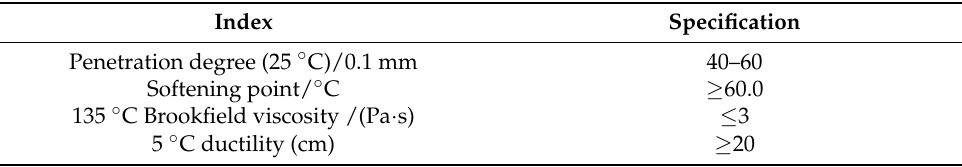
Figure 4. Relationship between Proportion of SBS in modifier and low temperature ductility. Table 9. Performance index of SBS modified